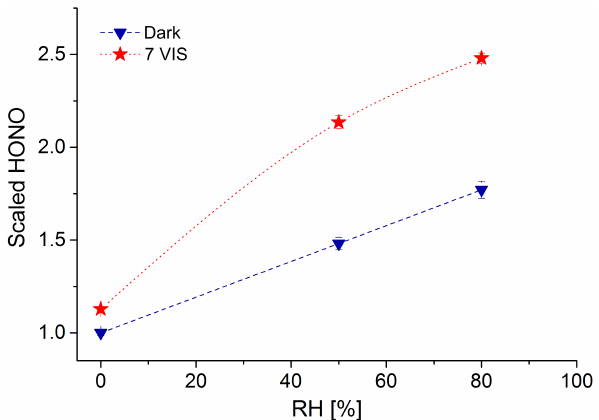
Figure 7. Dependency of relative humidity on HONO formation. 25ppb NO 2 was applied on BSA surface (17.5µgcm − 2 ) either in darkness (blue triangle) or at seven VIS lights (red star). HONO was scaled to HONO concentrations in darkness under dry con- ditions ( [ HONO ] lights on–off; RH / [ HONO ] dark;RH=0 ). Dotted lines are meant to guide the